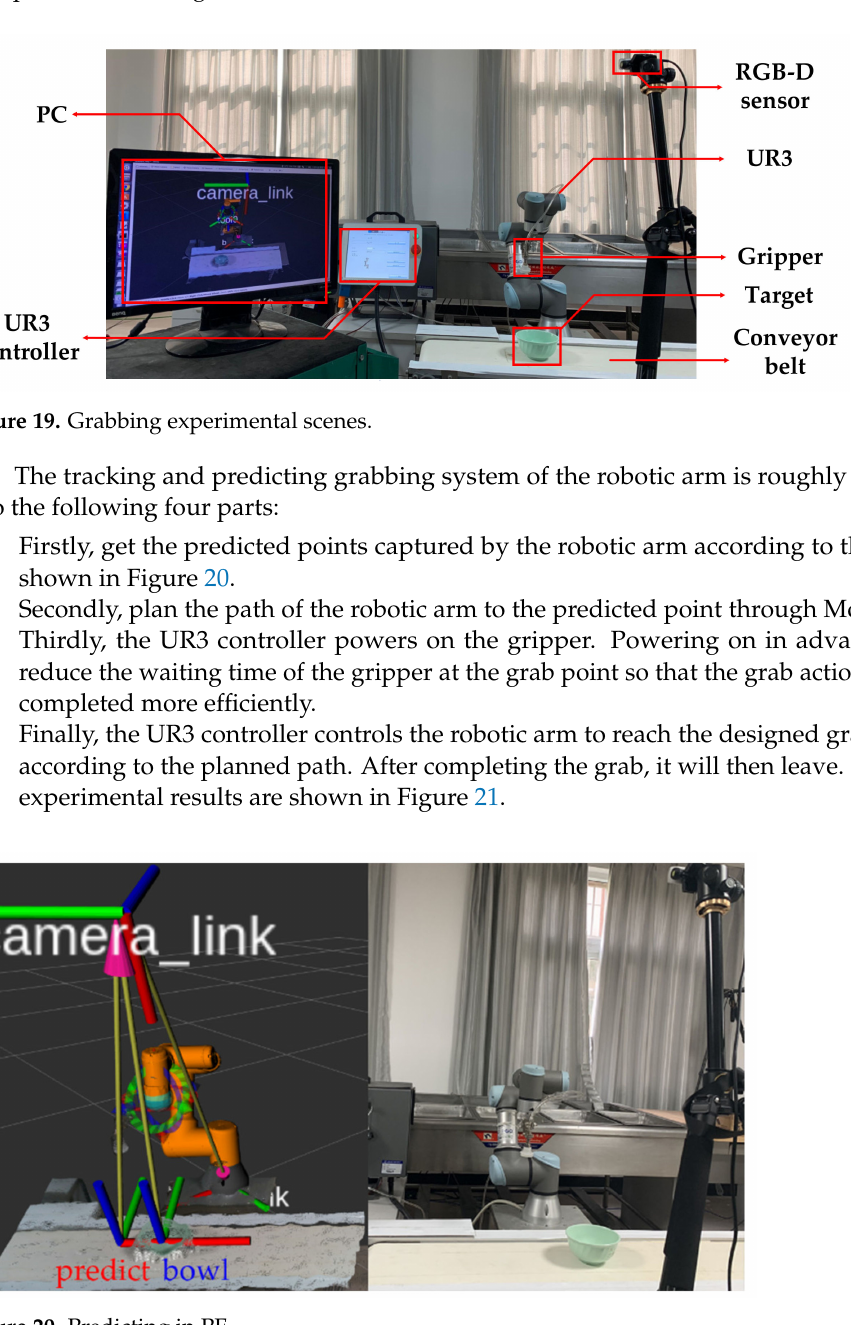
Figure 20. Predicting in